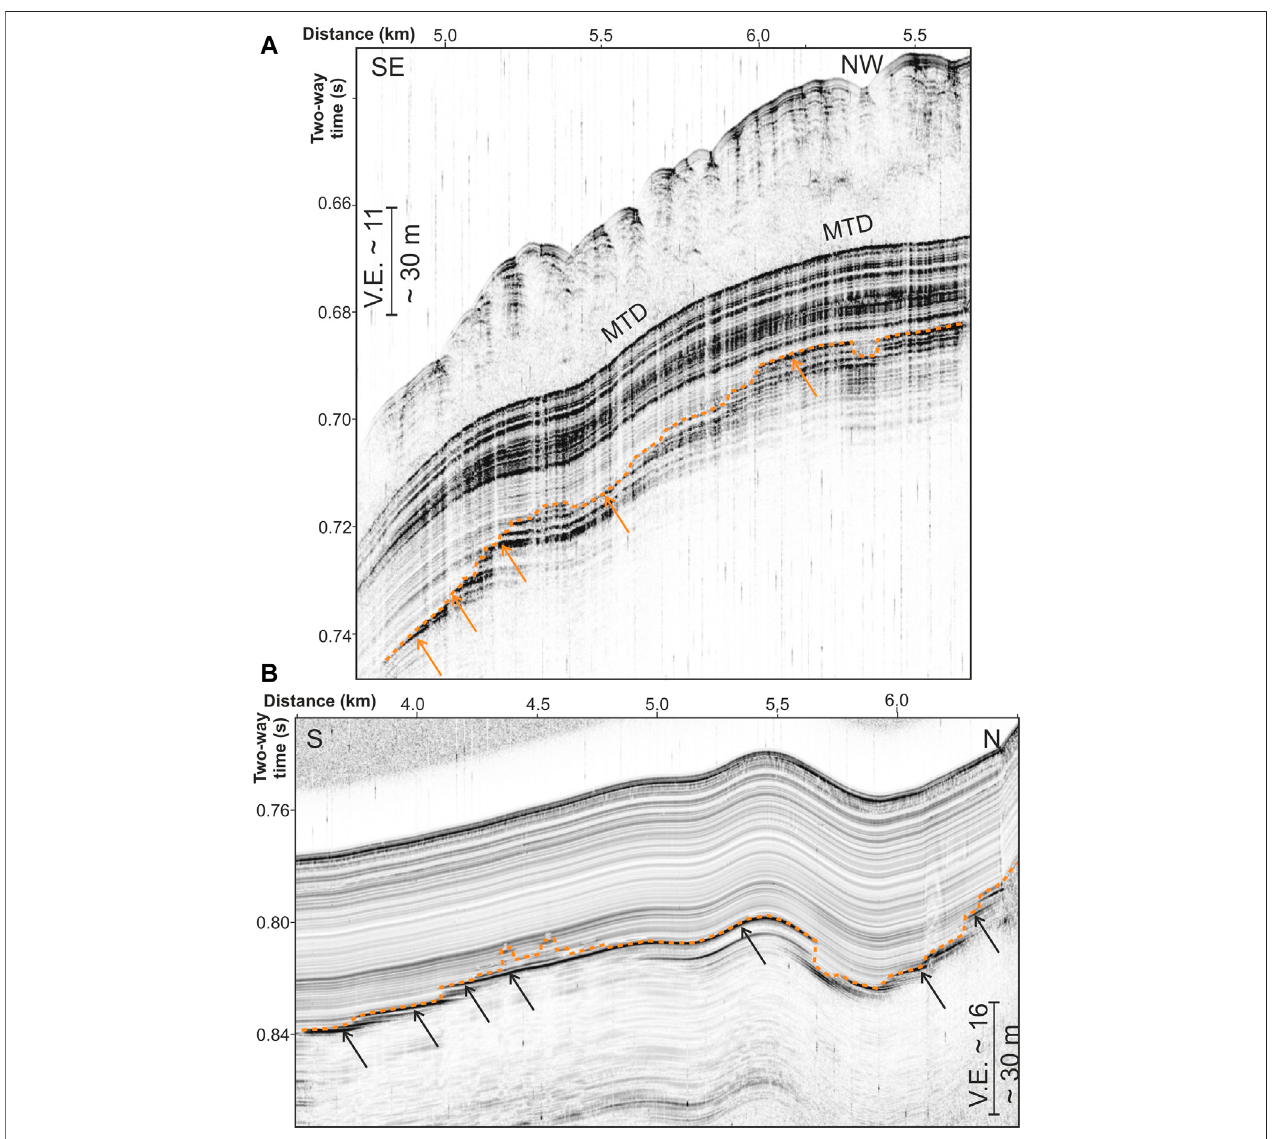
FIGURE15| Twoexamplesoffreegasinsedimentsenhancingthelayer ’ sre fl ectivitywithoutcreatinggas-masking. (A) ExampleneartheS2channel, (B) example from the eastern study region around the N2 channel. The free gas occurrences are marked by an increase in re fl ectivity (orange arrows and dotted line) of individual layers. As sea fl oor depth decreases, the top of free gas jumps to the next shallower sedimentary layer without forming a continuous (diffuse) gas front as observed in other locations (compare to Figure 14D ). This bottom-simulating nature is explained by the pressure and temperature dependence of methane gas solubility (see SupplementaryFigureS1 forschematicfunctions).Themass-transportdeposit(MTD)seenin (A) isalsomappedacrosstheregion(compareto Figure11 ,referredto as intermediate MTD 1).